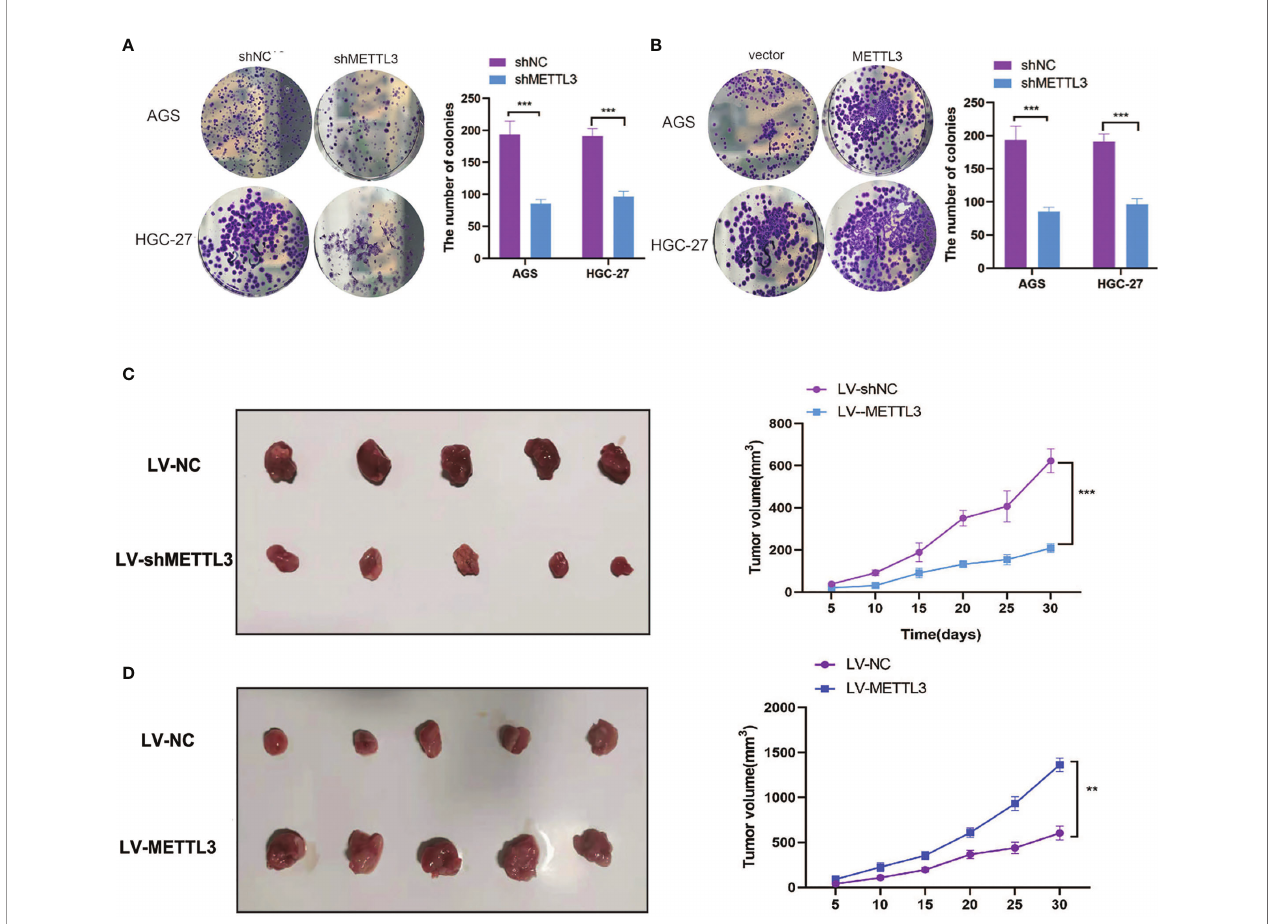
FIGURE 2 | METTL3 promotes GC growth in vitro and in vivo . (A, B) The proliferative ability of GC cells was evaluated after METTL3 knockdown or overexpression by colony formation assay. (C, D) The tumor formation was veri fi ed after METTL3 knockdown or overexpression in a xenograft model. **P < 0.01, ***P <